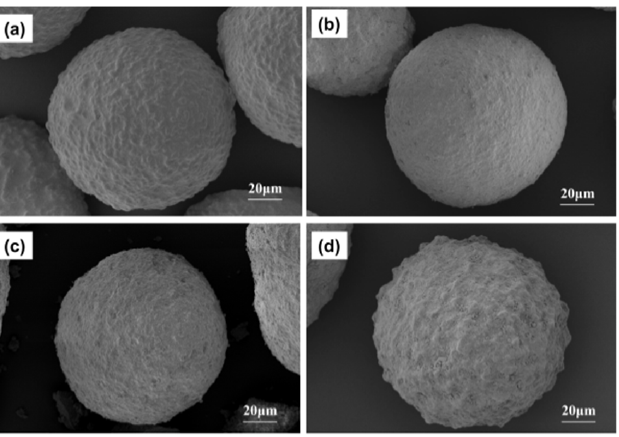
Figure 1. SEM micrographs of ( a ) E-cat, ( b ) CAT-MM1, ( c ) CAT-MM2, and ( d ) CAT-CD.